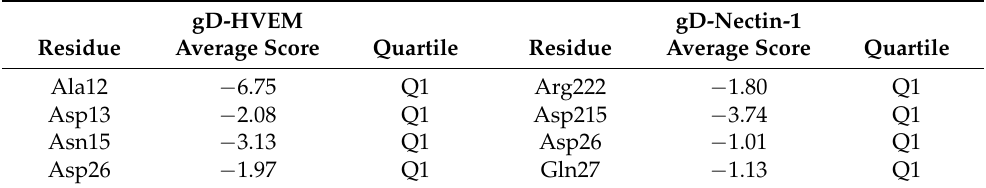
Table 4. GBPM average scores and quartile distribution of the pivotal hotspots of gD in complex to HVEM and Nectin-1, for all frames of